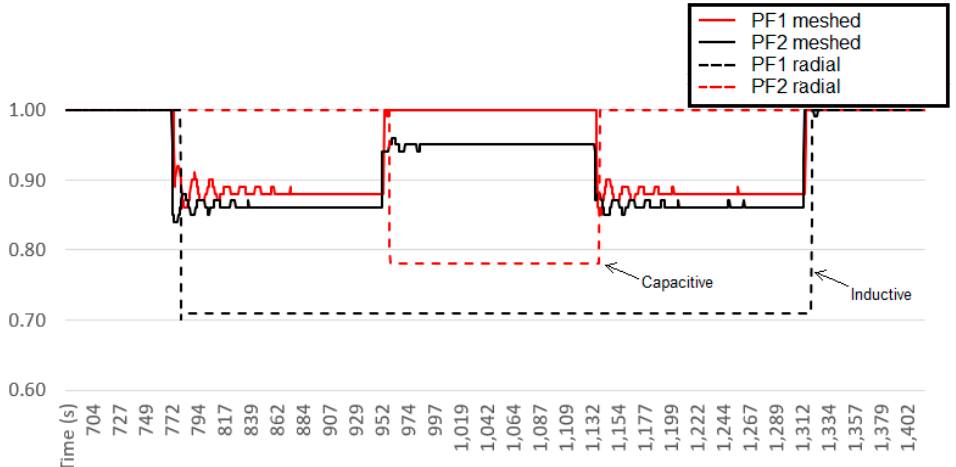
Figure 23. Power factor measurements at the beginning of feeders A and B.